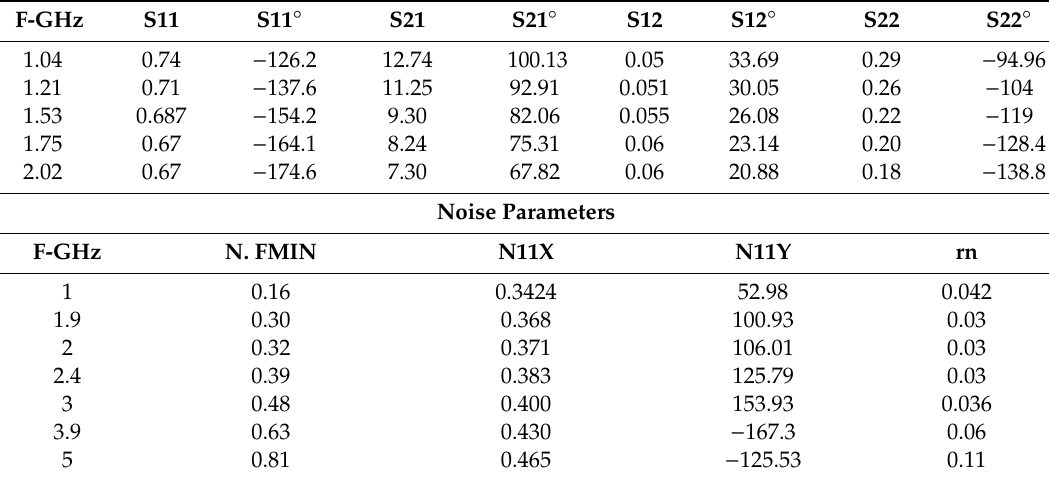
Table 2. LNA S parameters and noise parameters at the S band.